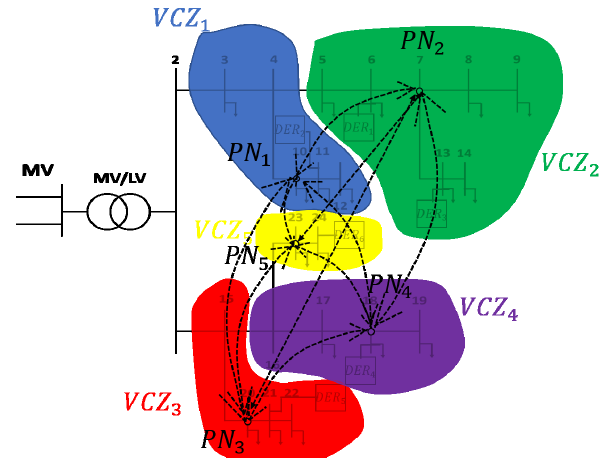
Figure 6. Communication of scalar variables among